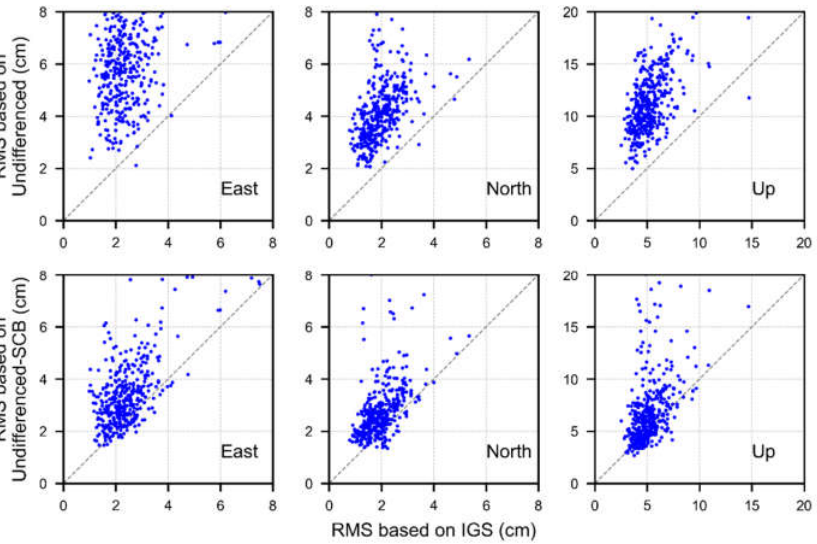
Figure 12. RMS of positioning errors for different PPP solutions when compared to IGS weekly solutions at 57 stations from DOY 031 to 037.